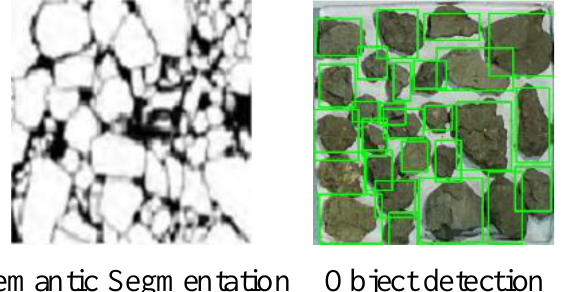
Figure 2. Illustration of semantic segmentation and object detection annotation. Semantic segmenta- tion requires pixel-level annotation while object detection requires only bounding